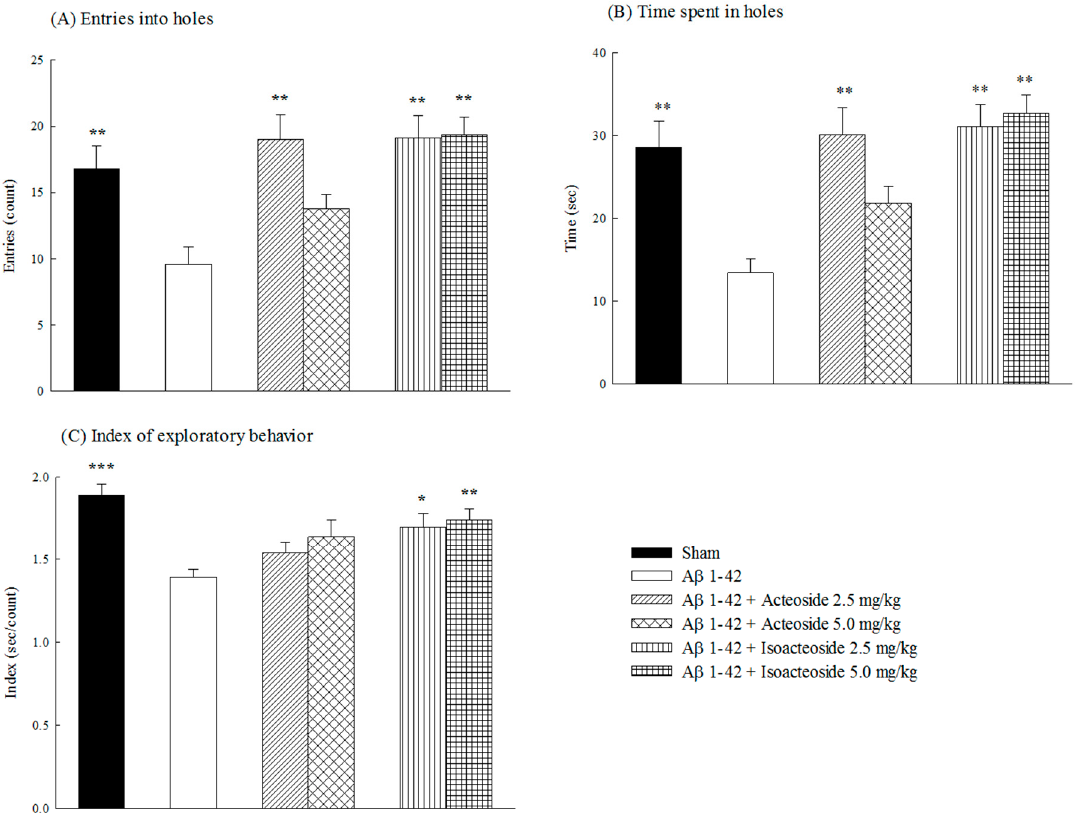
Figure 2. Effects of acteoside or isoacteoside (2.5, 5.0 mg/kg; po) on: ( A ) the number of entries into holes; and ( B ) time spent in holes; and ( C ) index of exploratory behavior in A β 1-42-infused rats. Exploratory test was performed on Day 7 following A β 1-42 infusion. Acteoside or isoacteoside was continuously administered after A β 1-42 infusion until all rats were sacrificed. Columns indicate mean ± SEM ( n = 12). * p < 0.05, ** p < 0.01, *** p < 0.001 compared with A β 1-42-infused rats.